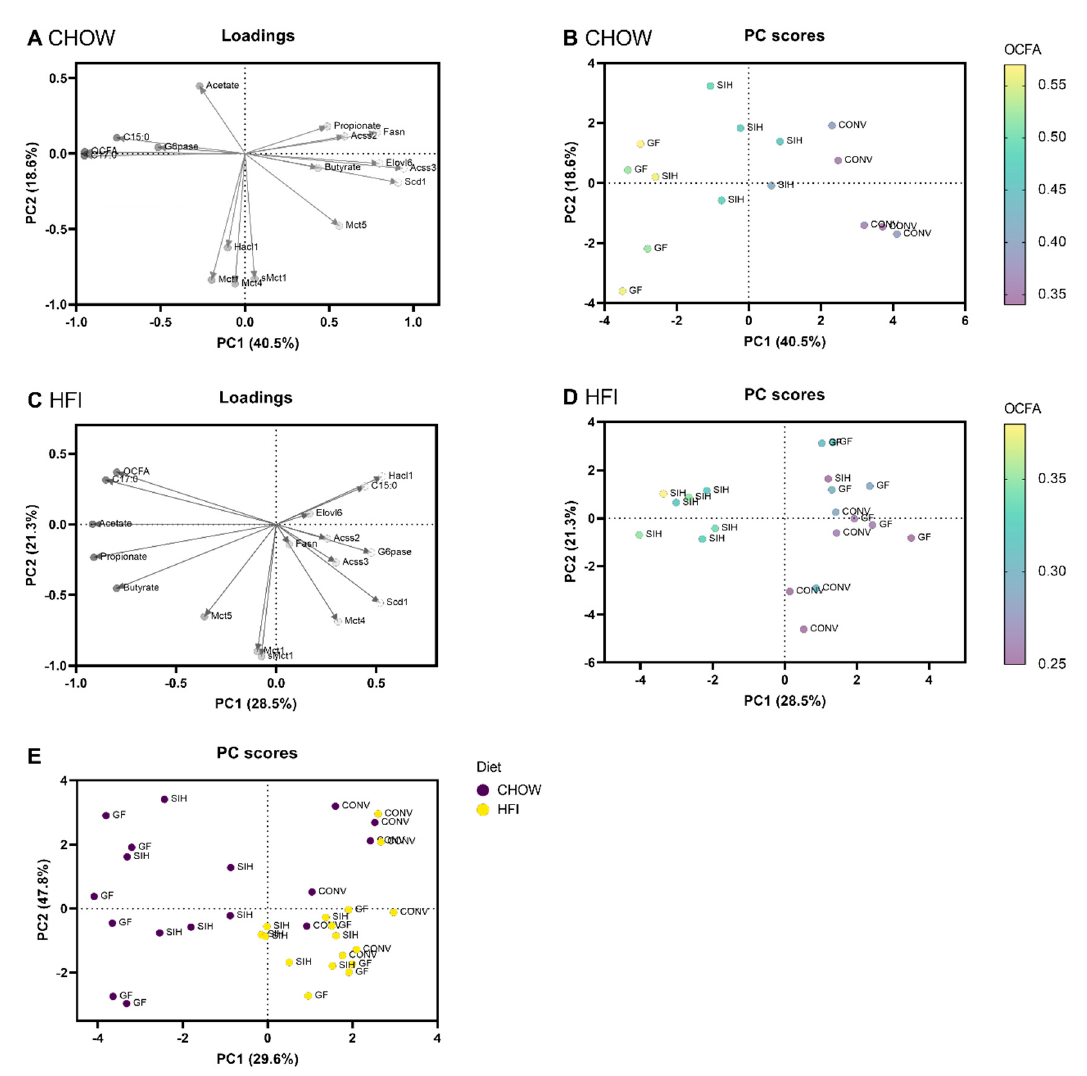
Figure 6. Principal component analysis (PCA) showing the loading plots and score plots of data, including OCFA formation, cecal SCFA concentrations and mRNA expression in the liver and intestines of male C3H/HeOuJ mice on ( A , B ) CHOW (Altromin fortified 1314) or ( C , D ) high-fat inulin diets (HFI, high-fat + 7% inulin) harboring a germ-free (GF), simplified human (SIH) or conventional (CONV) microbiota. ( E ) PC scores showing the distinct profile of CHOW-fed mice compared to HFI mice, independent of colonization status (GF vs. SIH vs. CONV).